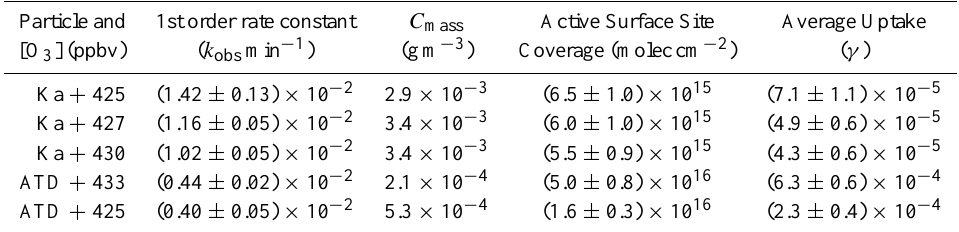
Table 1. List of kinetic variables calculated from O 3 ageing of MD particles. Ozone concentrations indicated in the first column are initial concentrations just before introducing aerosol into the tank but after accounting for background wall